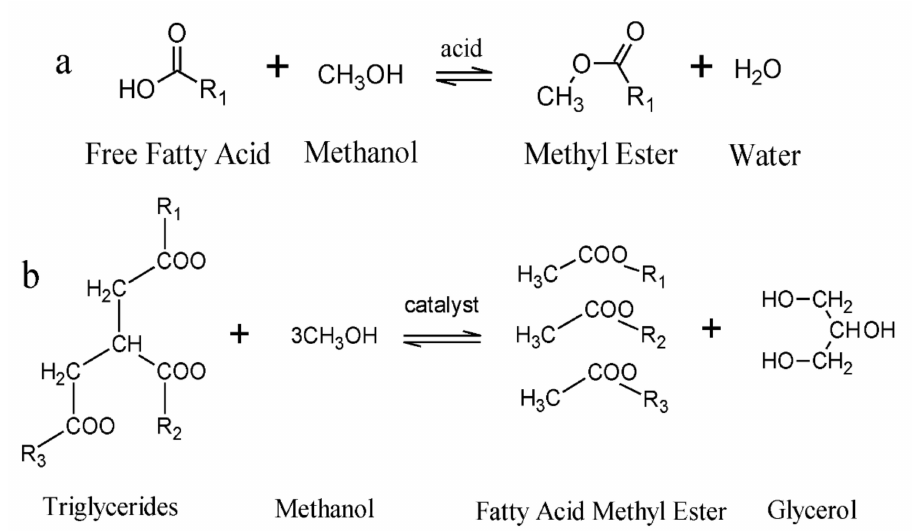
Figure 1. Over view of the chemical reaction ( a ) acid-catalyzed esterification and ( b ) base-catalyzed transesterification reaction pathways [124].